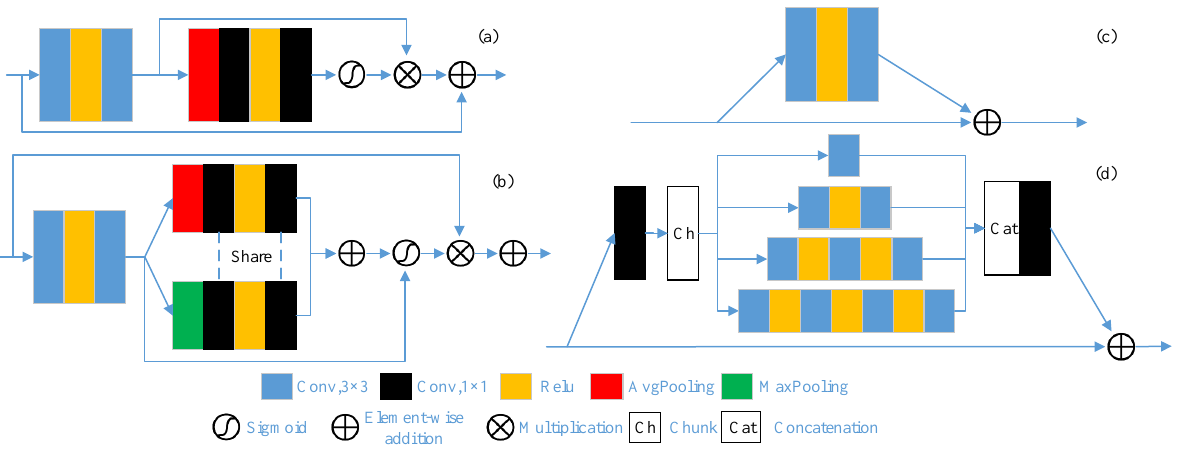
Figure 3. The structures of the candidate networks. ( a ) RCAM; ( b ) SeAM; ( c ) traditional ResNet; ( d ) MSRNet.